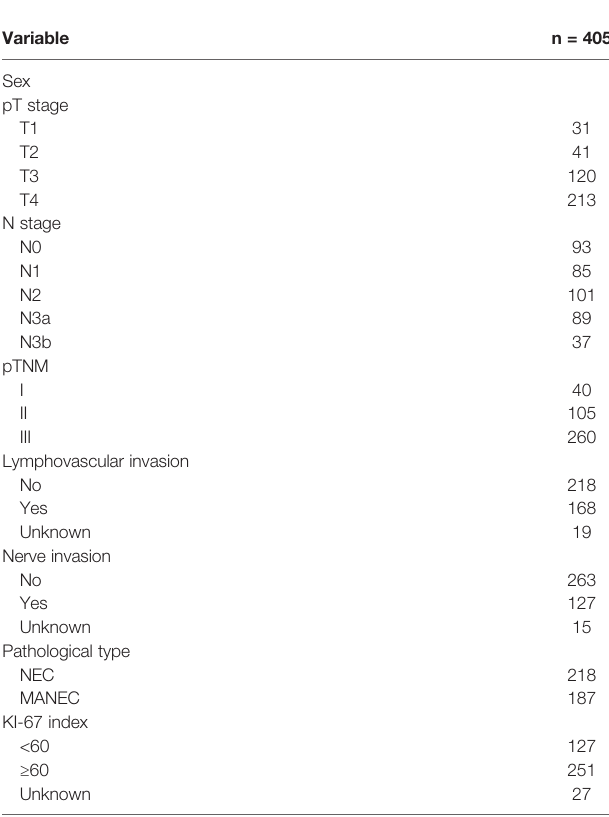
TABLE 1 | Clinicopathological